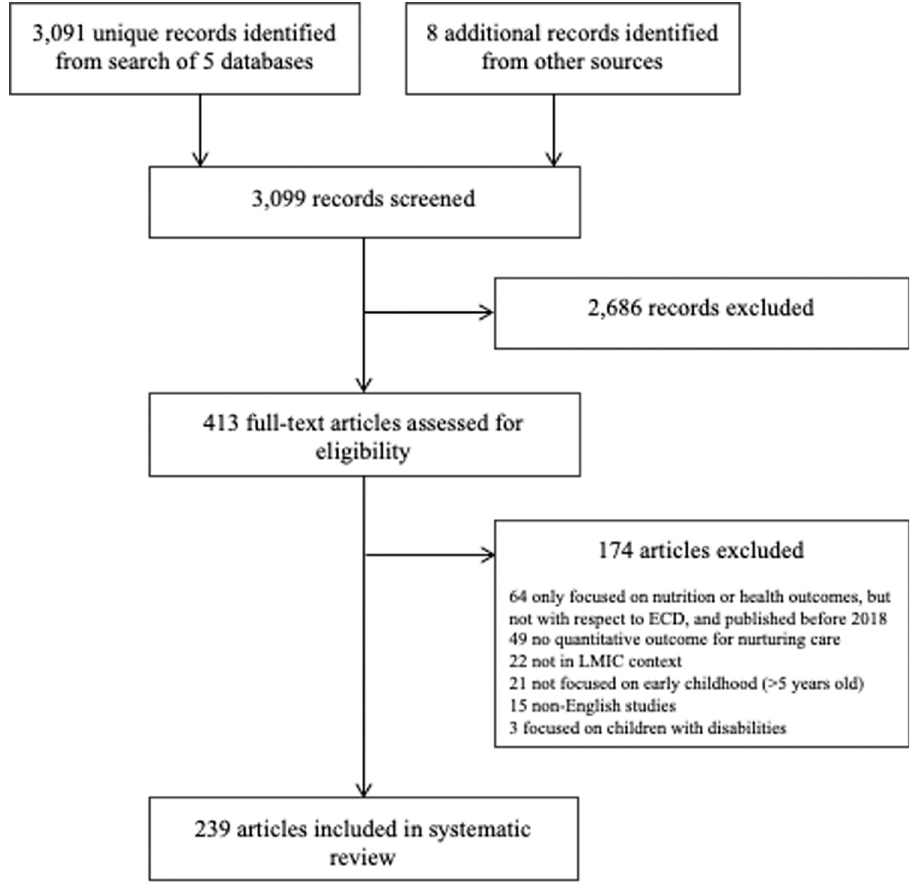
Fig 1. PRISMA flow diagram of search results and